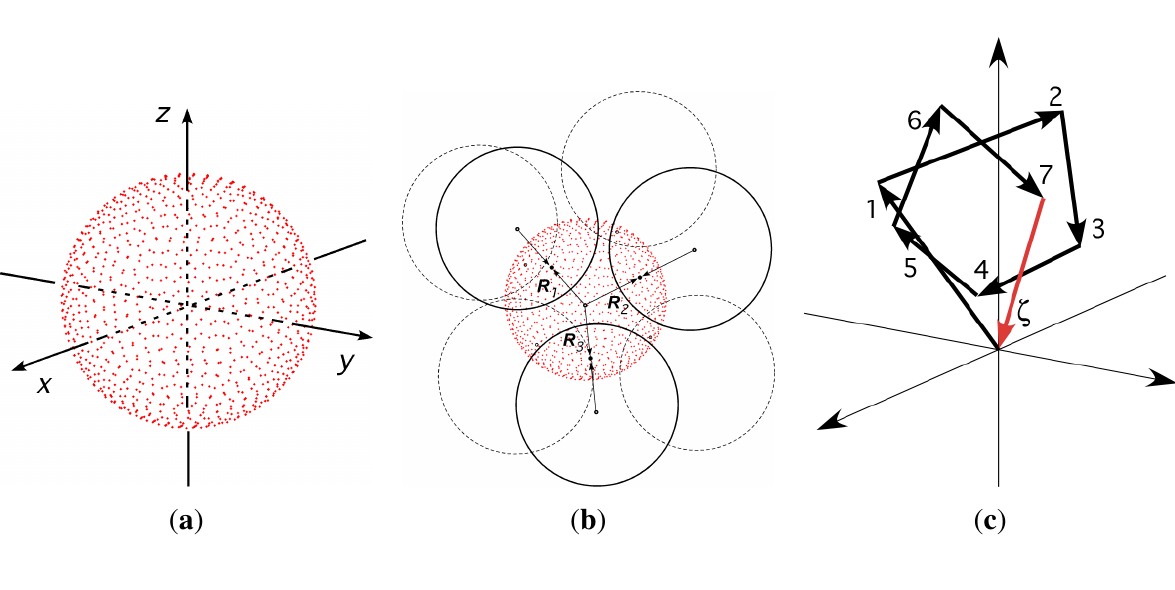
Figure 12. Formation of an irregular cluster as a seed for random packing of spheres by the method of To et al. [17]. On left, a sphere with 3 . 6 × 10 3 equally spaced points. Centre, k = 7 points selected at random and spheres added without overlap: π/ 3 ≤ φ ( R On right, vector polygon formed by radial vectors R